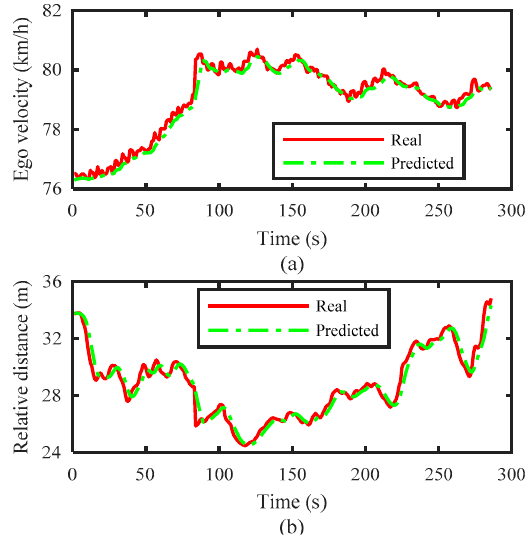
Figure 6. The application results of driver behavior mimic.